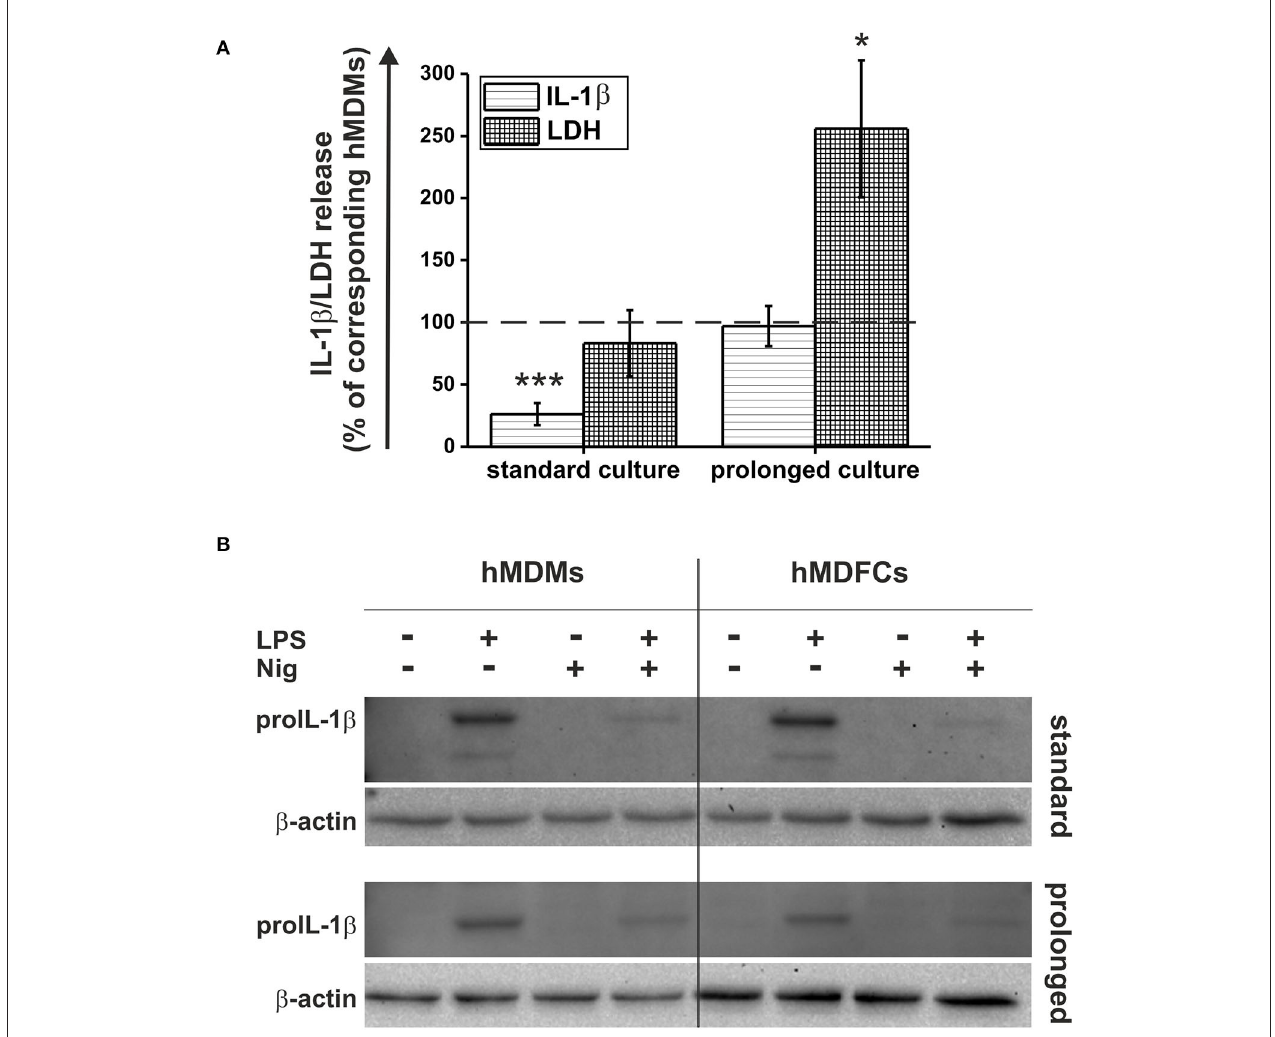
FIGURE 7 | Pyroptosis and IL-1 β secretion by hMDFCs obtained by standard and prolonged cell culture. Standard/prolonged-hMDMs/hMDFCs were obtained as indicated in Materials and Methods, and Figure 1 . Cells were stimulated with 1 µ g/mL stLPS for 4h and 10 µ M nigericin for next 20h. (A) Levels of IL-1 β and LDH activity in supernatants were determined by ELISA and Pierce TM LDH Cytotoxicity Assay Kit, respectively. Results for hMDFCs were expressed as a percent of IL-1 β secretion and LDH release by corresponding standard- and prolonged hMDMs (100% indicated with dashed horizontal lines). Bars and error bars represent means ± SEM from seven independent experiments (each in duplicate, n = 14). * p < 0.05, *** p < 0.001 vs. hMDMs. Raw data of IL-1 β production and LDH release were shown in Supplementary Figure 2 . (B) ProIL-1 β expression was determined in whole-cell lysates from hMDMs and hMDFCs using immunoblotting. Enhanced chemiluminescence signal was detected with Bio-Rad ChemiDoc XRS + system. β -actin level was determined as a loading control. Images shown are representative of three independent experiments